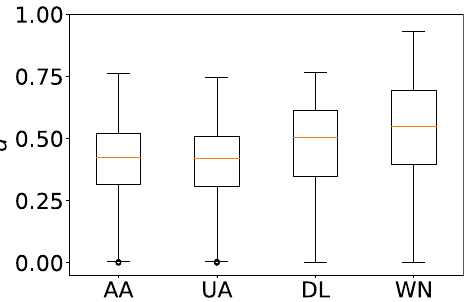
Figure 3. The distribution of the network distance d . The box plots show five-number summaries of the distribution: first quartile ( Q 1 ), median, third quartile ( Q 3 ), minimum without outliers ( Q 1 maximum without outliers ( Q 3